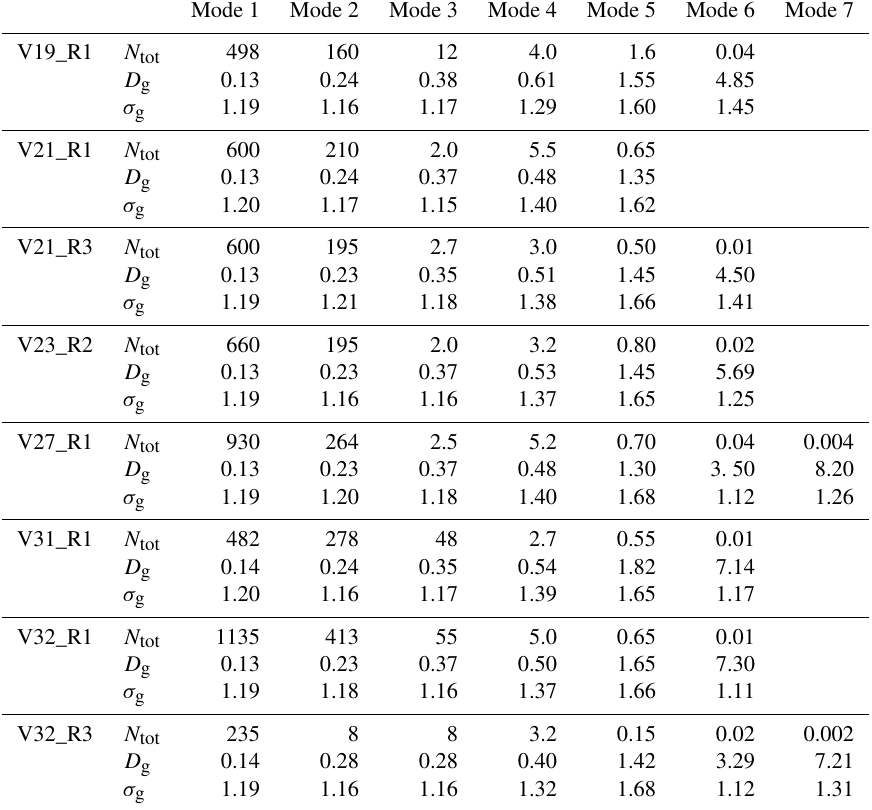
Table 3. Lognormal mode parameters of the measured aerosol size distribution (total aerosol number concentration, N tot , median diameter, D g , and geometric standard deviation, σ g ) . Data correspond to SLRs below ∼ 350m altitude. Diameters are given in microns and number concentrations are given in particles per cm − 3 and refer to ambient conditions.